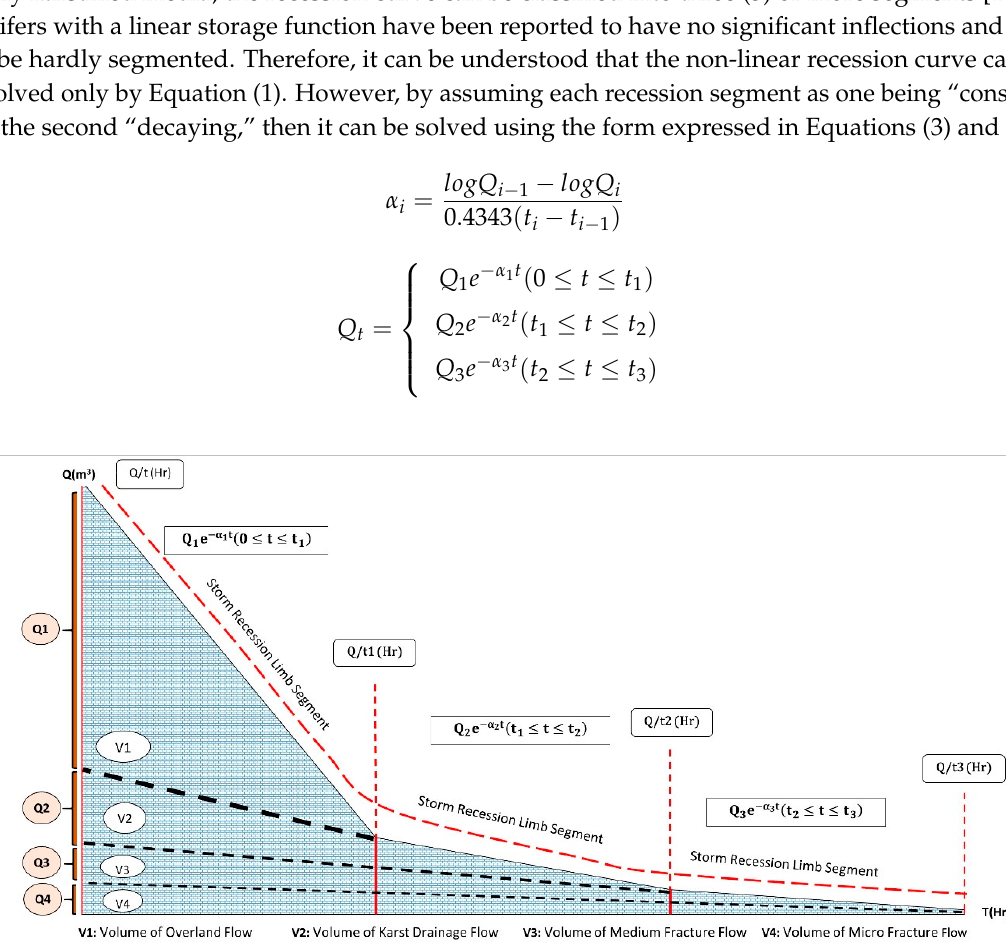
Figure 4. Schematic presentation of the hydrograph recession limb with four recession segments and corresponding volumes of discharged water (adapted from Kresic N. and Bonacci O. [39]).